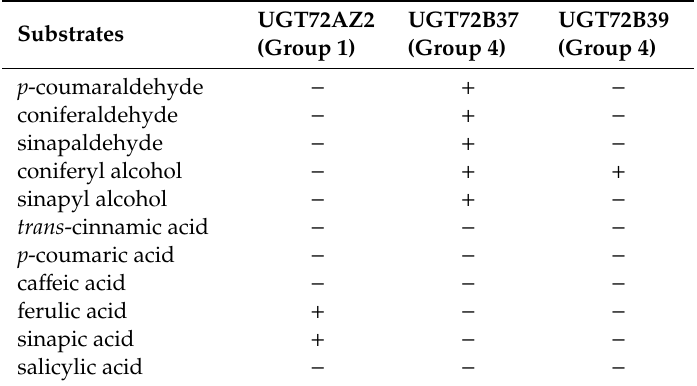
Table 1. Poplar UGT72s activity towards di ff erent